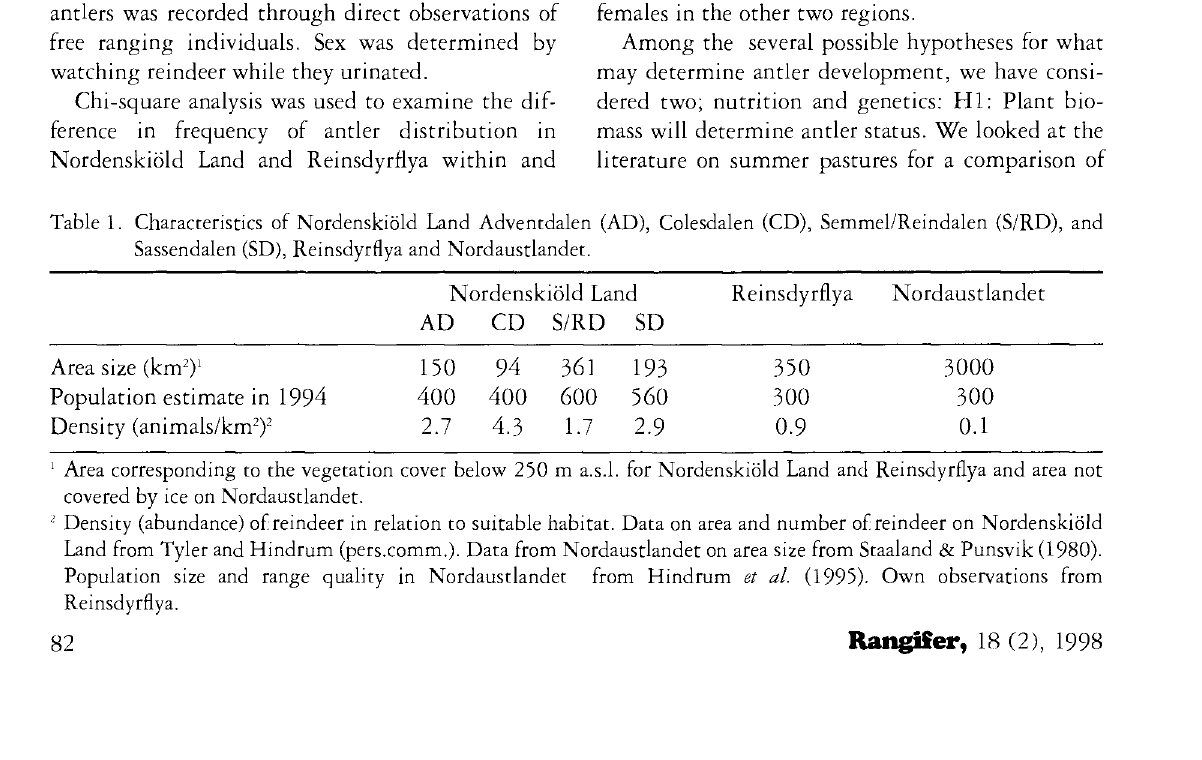
Fig. 1. Map over study areas: Nordenskiold Land (NL), Reinsdyrflya (RF), and Nordaustlandet (NA).